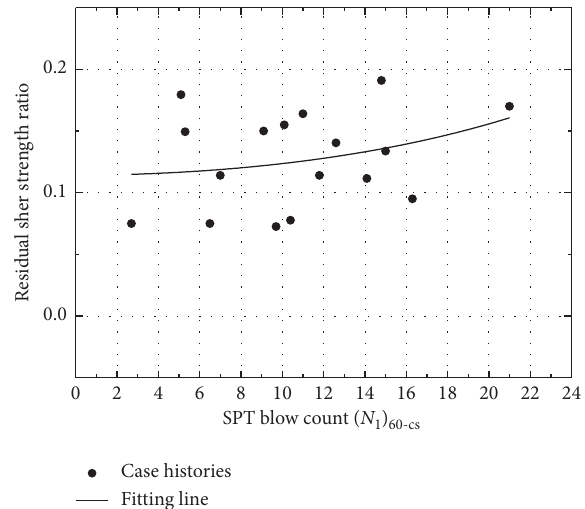
Figure 5: Predicted lateral spreading versus observed lateral spreading.